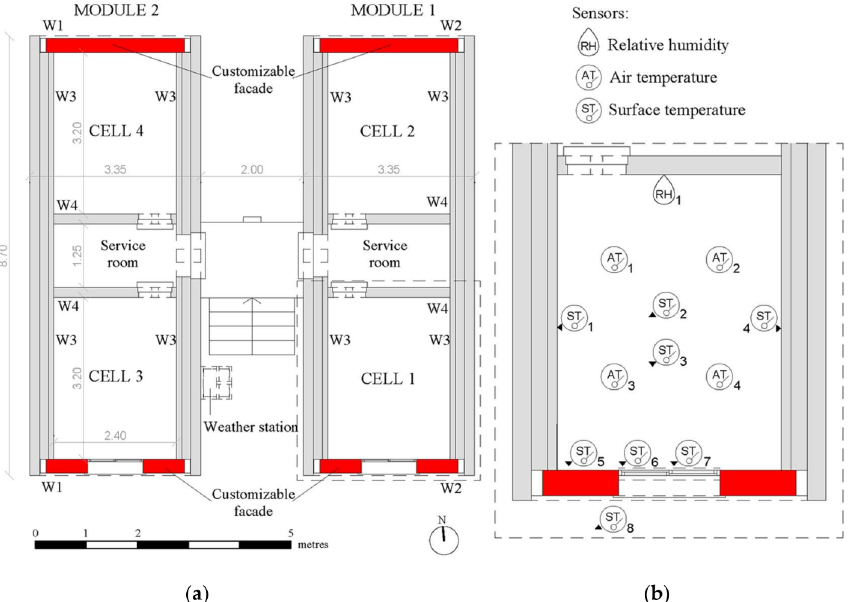
Figure 3. ( a ) Floor plan of the test cells: ETICS facades (W2) in Cells 1 and 2, and basic facades (W1) in Cells 3 and 4; and ( b ) location of the sensors within each test